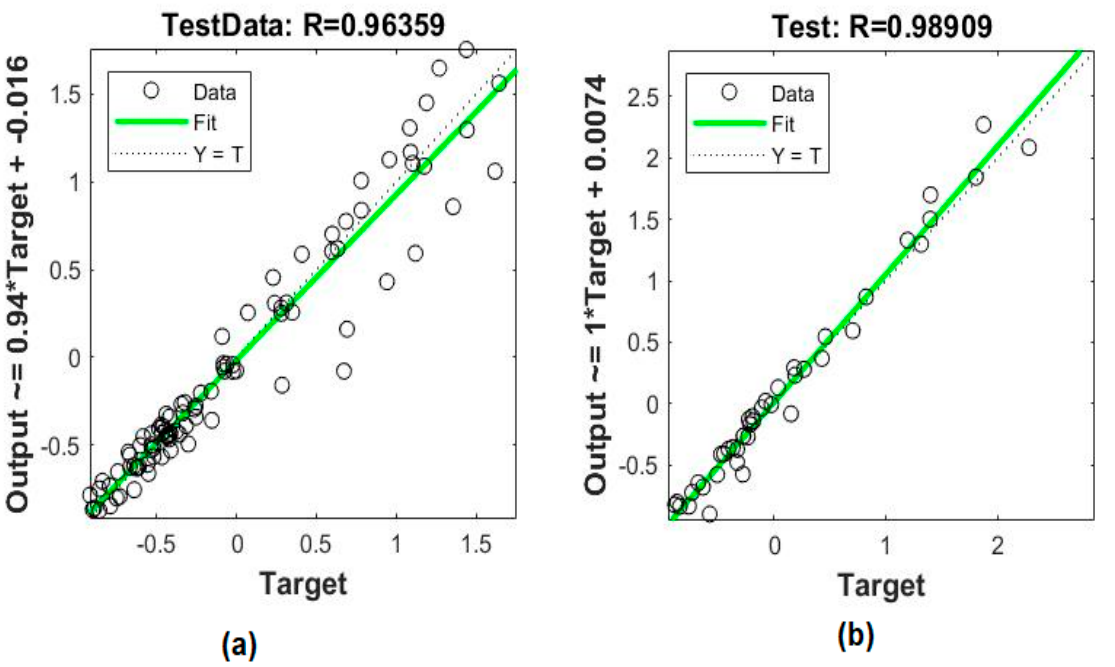
Figure 6. Regression plot for predicting bitcoin price: ( a ) GRU model and ( b ) MLP model.